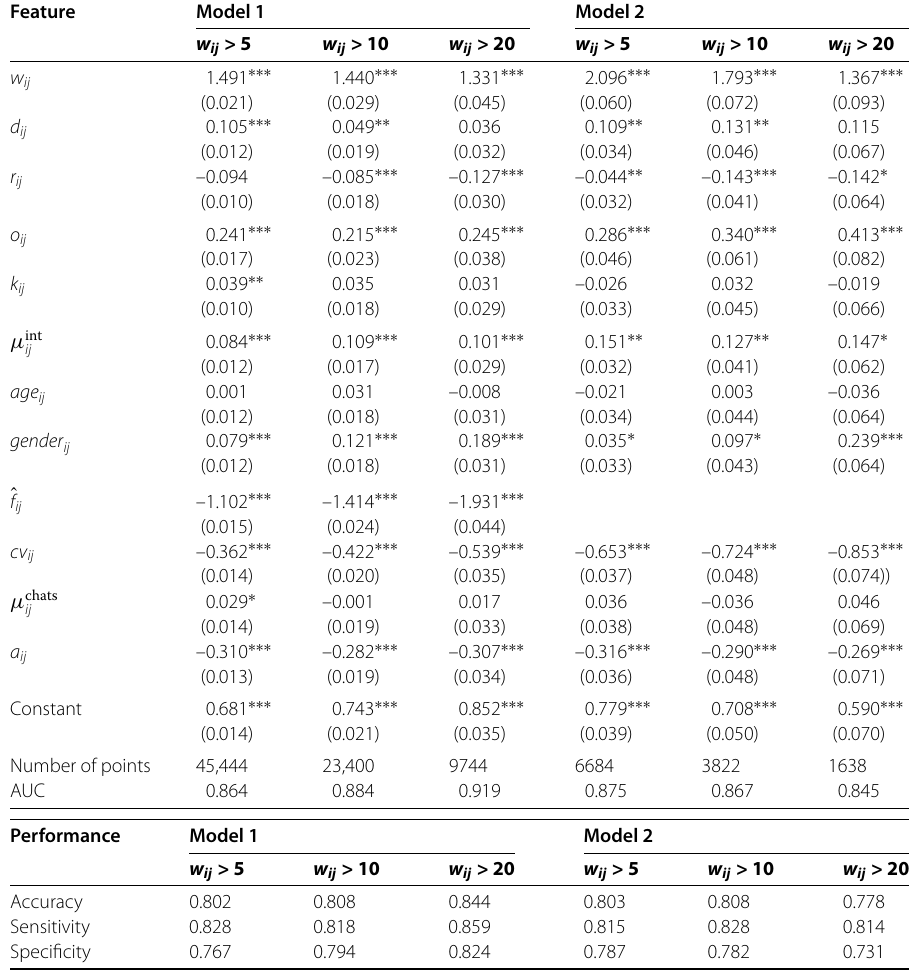
Table 3 Regression results for tie persistence using generalized linear models for the two prediction models and different thresholds for the number of calls w